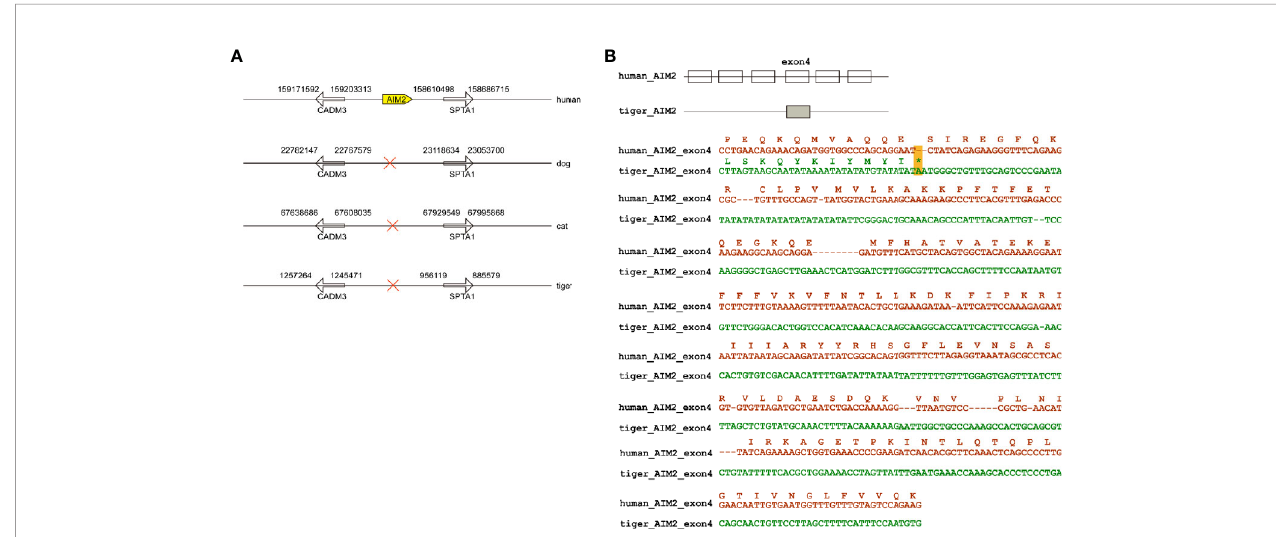
FIGURE 1 | Natural deletion of AIM2 in tiger genome. (A) AIM2 genes are not present in dogs, cats, and tigers. (B) Exons are represented by boxes. Nucleotide sequences of tigers and humans were aligned. In-frame stop codon is highlighted by yellow